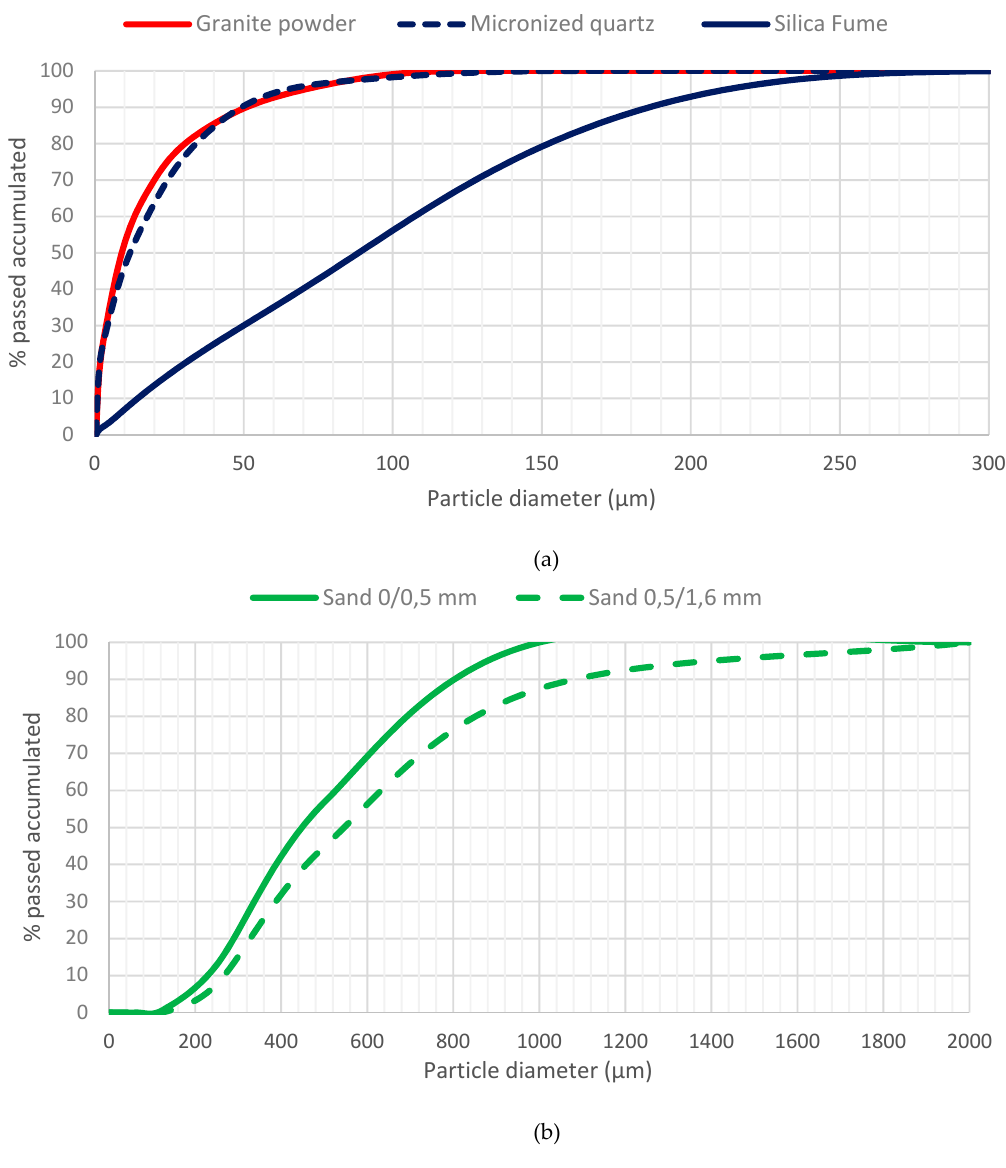
Figure 2. Size distribution. ( a ) Granite powder, micronized quartz and silica fume; ( b ) coarse and fine sand. Table 2. Materials properties .